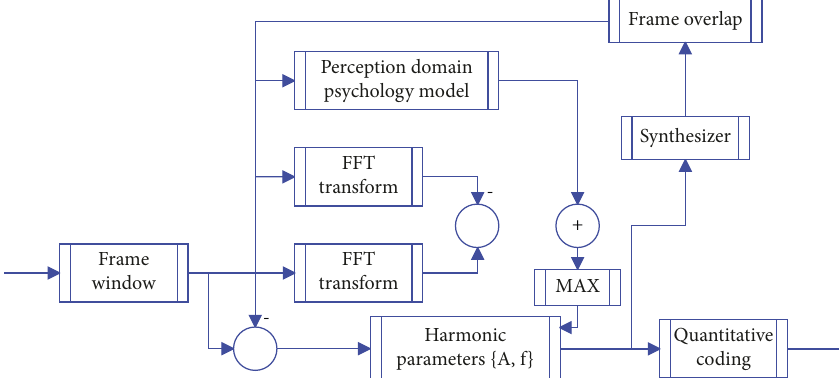
Figure 6: Block diagram of the parametric audio encoder